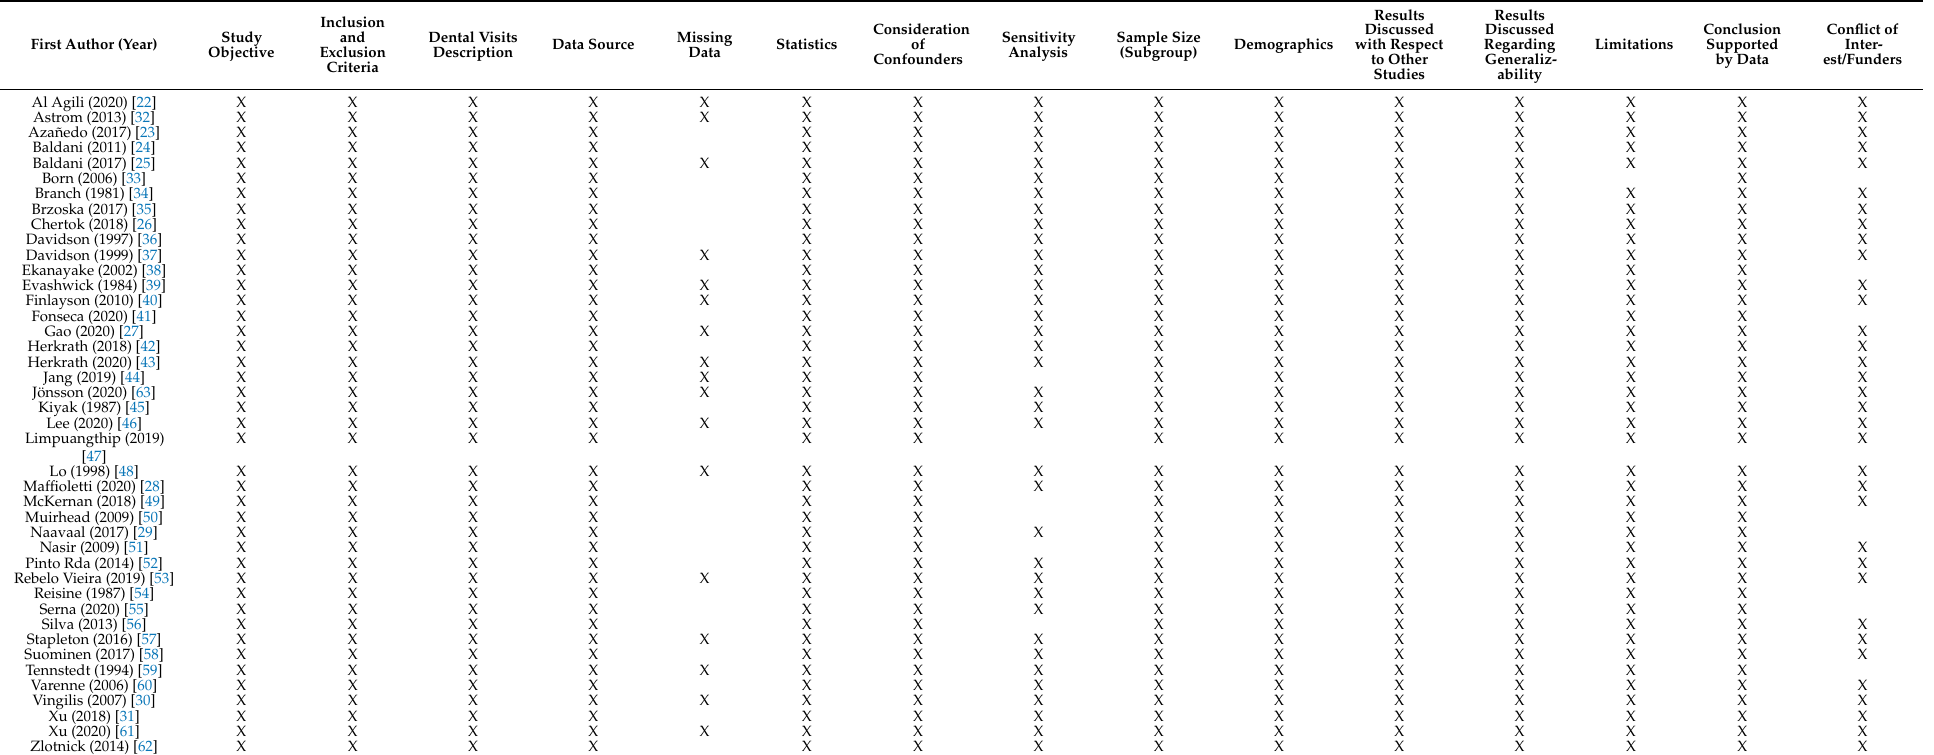
Table 6. Quality